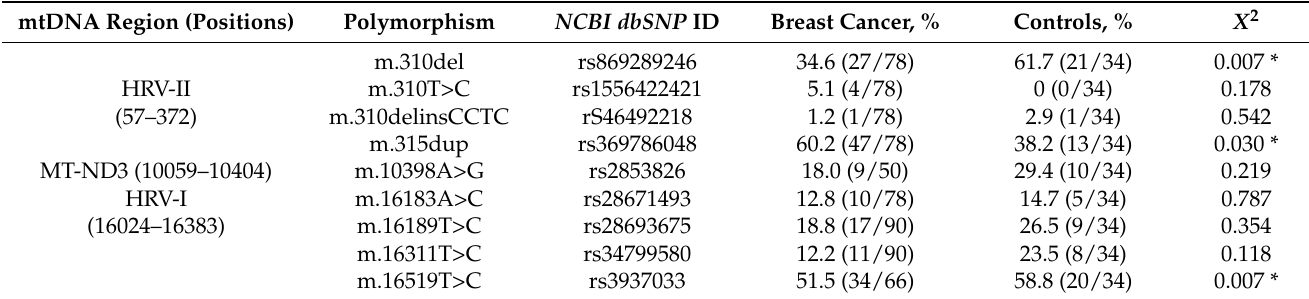
Table 1. Frequent polymorphisms in different mtDNA regions of the breast cancer cases and the controls.